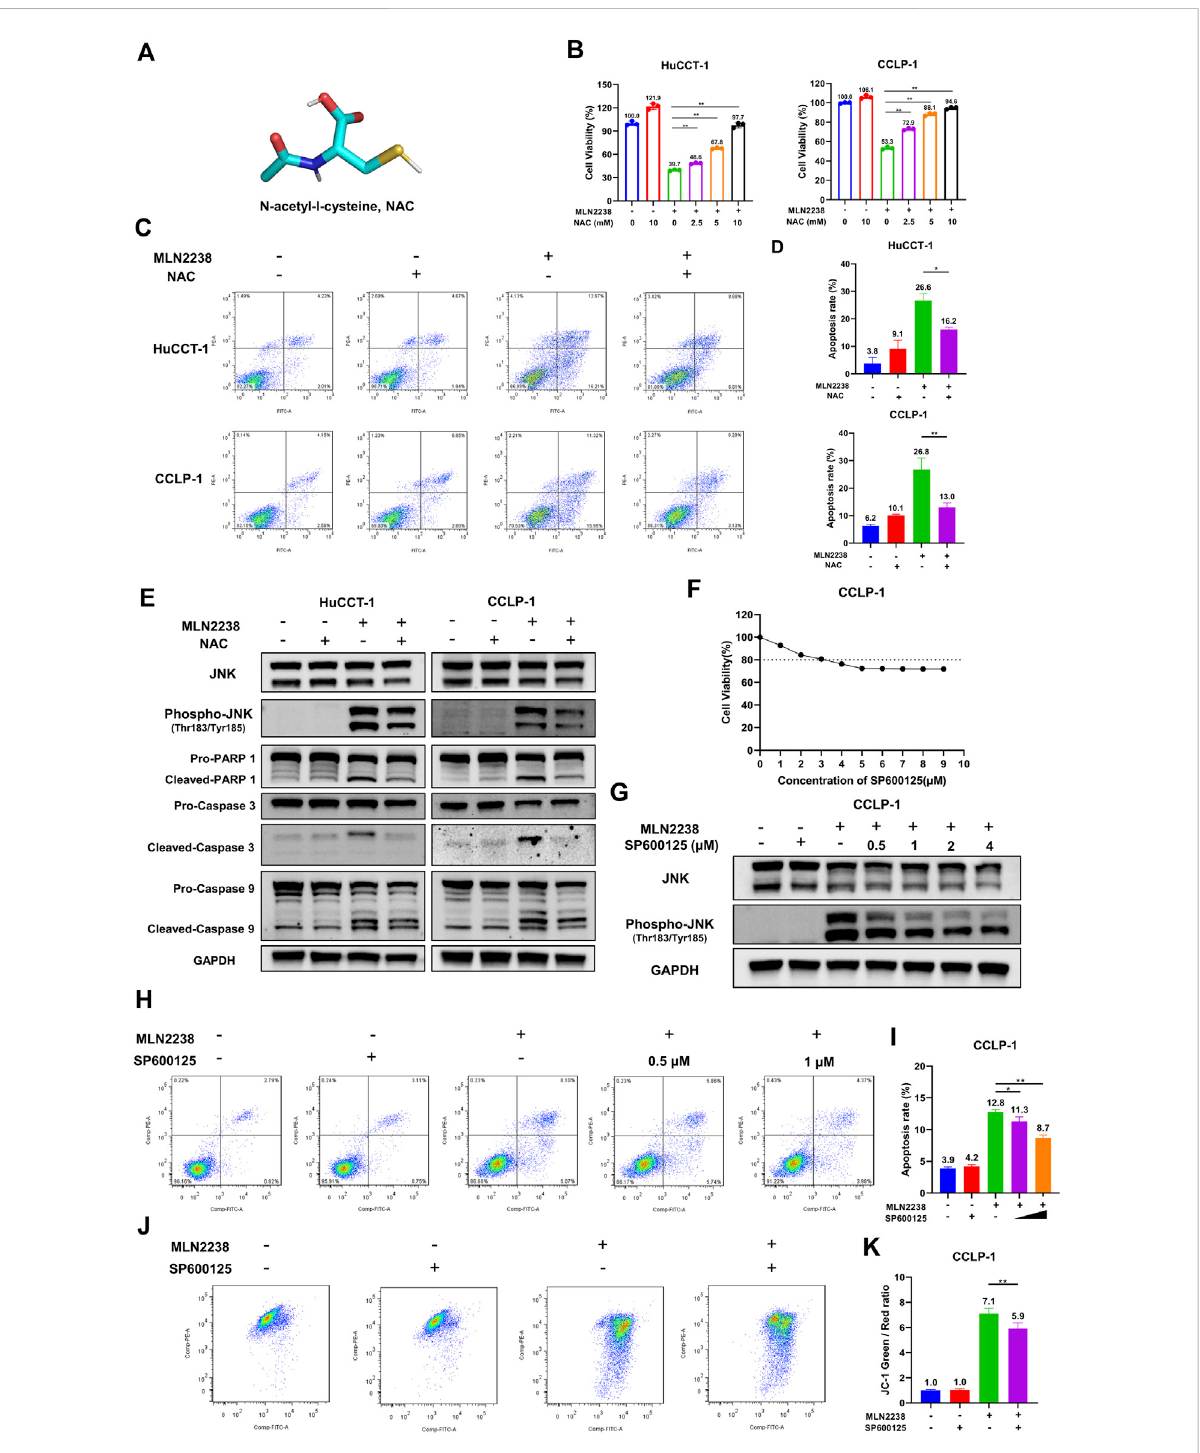
FIGURE 7 Inhibition ROS and JNK activation reversed the apoptosis induced by MLN2238 in iCCA cells. (A) Chemical structures of N-Acety-L-Cysteine (NAC). (B) The effect of MLN2238 on cell viability of HuCCT-1 and CCLP-1 cells were reversed by NAC. (C) NAC reversed the apoptosis of iCCA cells induced by MLN2238 treatment. (D) The histograms display the apoptosis rates of MLN2238 and NAC treatment. (E) The expression levels of JNK, phospho-JNK(Thr183/Tyr185) and apoptotic-related protein after IC50 concentration MLN2238 and 10 mM NAC treatment were analyzed via Western Blotting. (F) CCLP-1cell wastreatedwith various concentrationsofSP600125 for 24h,and cellcountingkit-8wasusedto measure thecell viability. (G) Western Blots was performed to detected the JNK and phospho-JNK(Thr183/Tyr185) protein expression levels after MLN2238